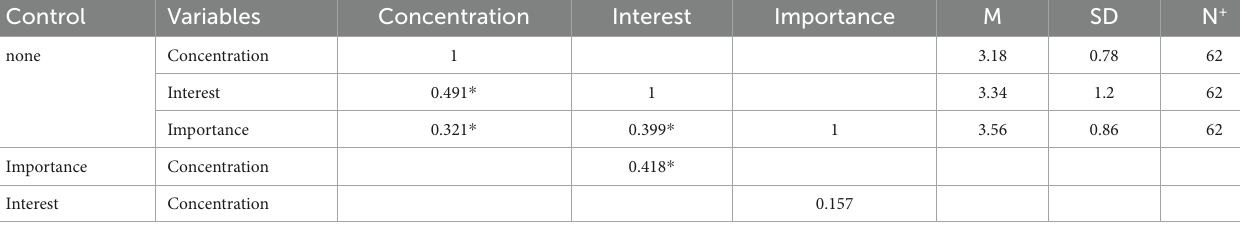
TABLE 5 Bi-variate and partial correlations among concentration, interest, and